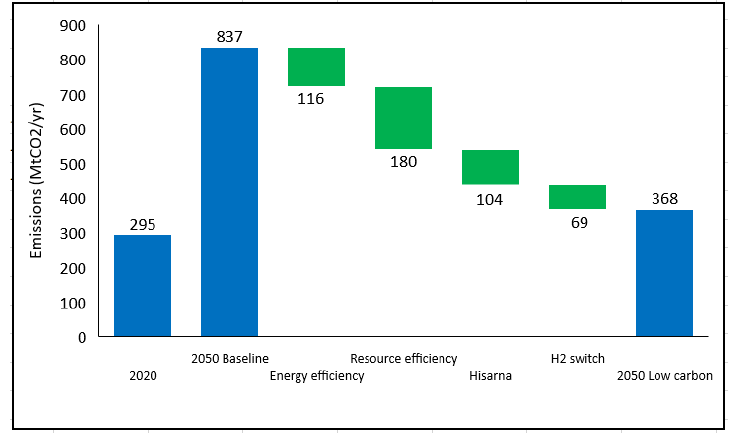
Figure 10. Emission reduction potential of the Indian iron and steel sector Reprinted with permission from TERI [31] Copyright 2020, The Energy and Resources Institute.